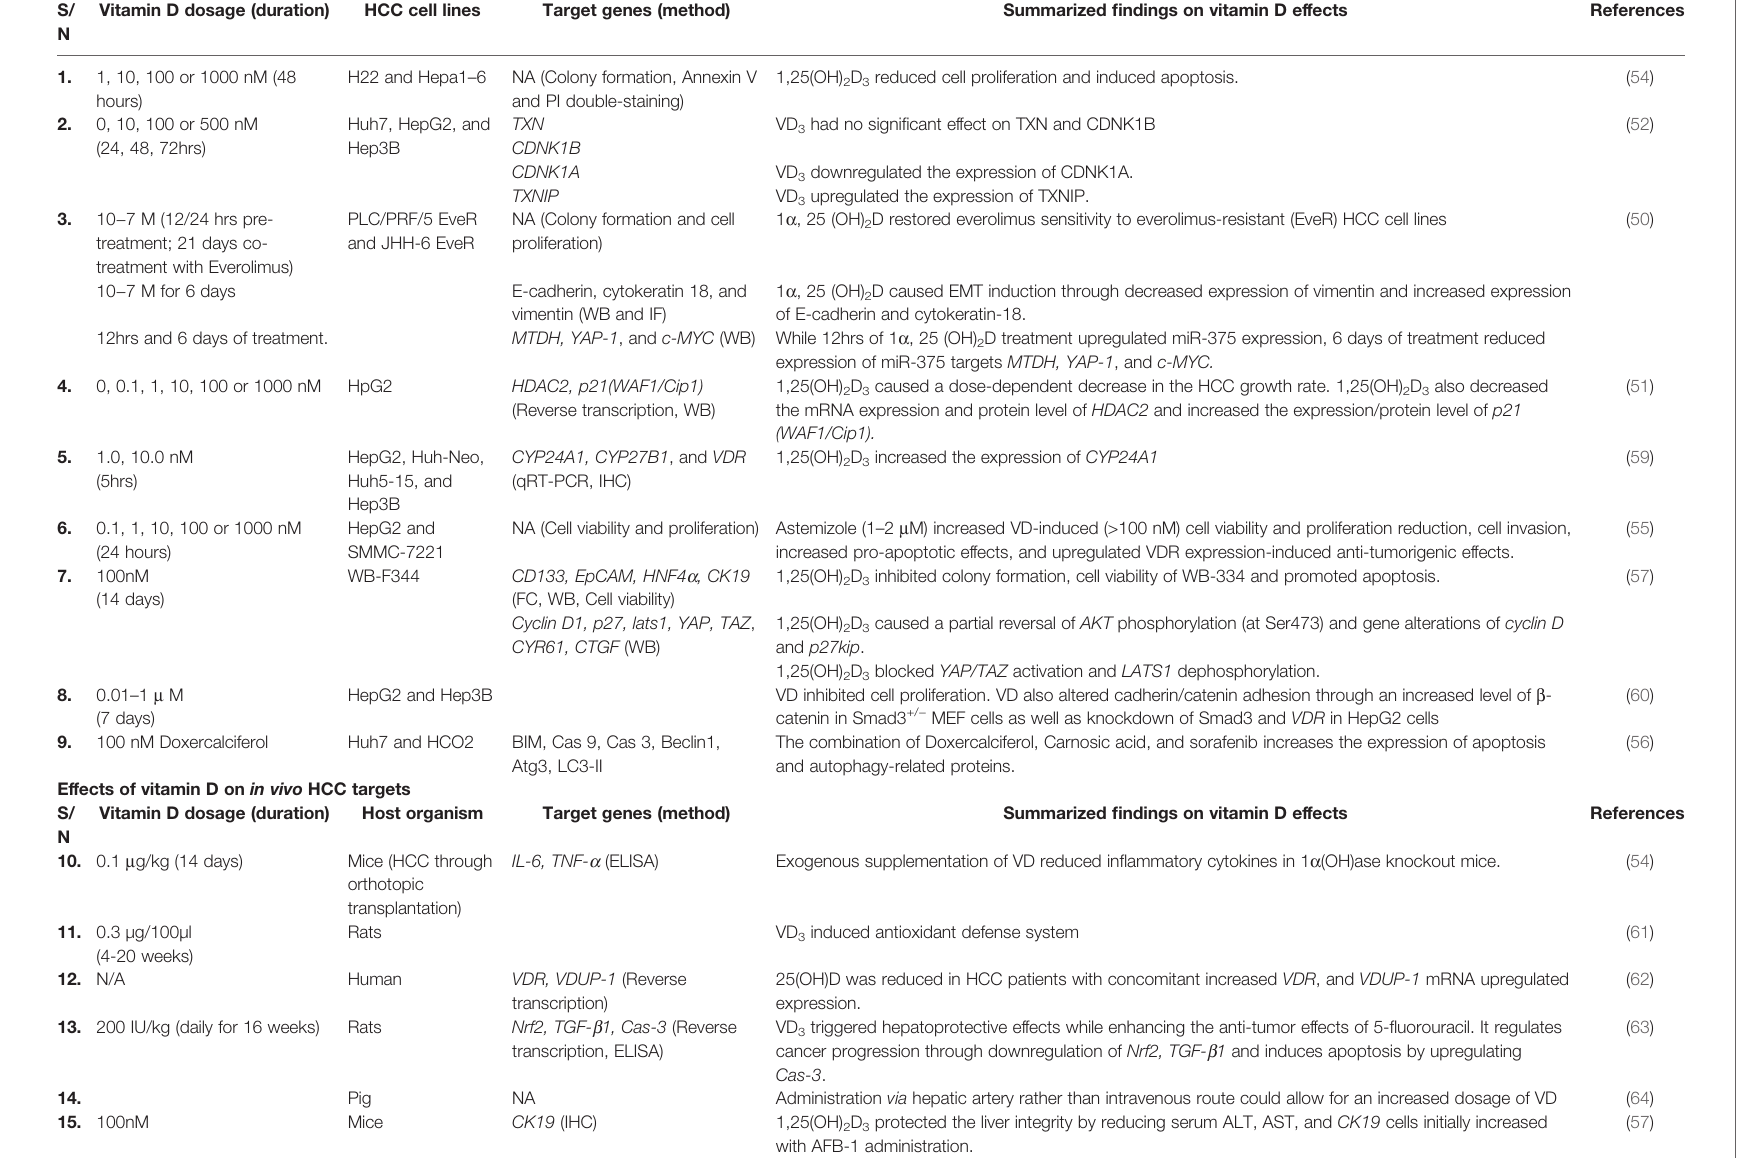
TABLE 1 | Summary of the effects of vitamin D on HCC targets genes. Effects of vitamin D on in vitro HCC targets